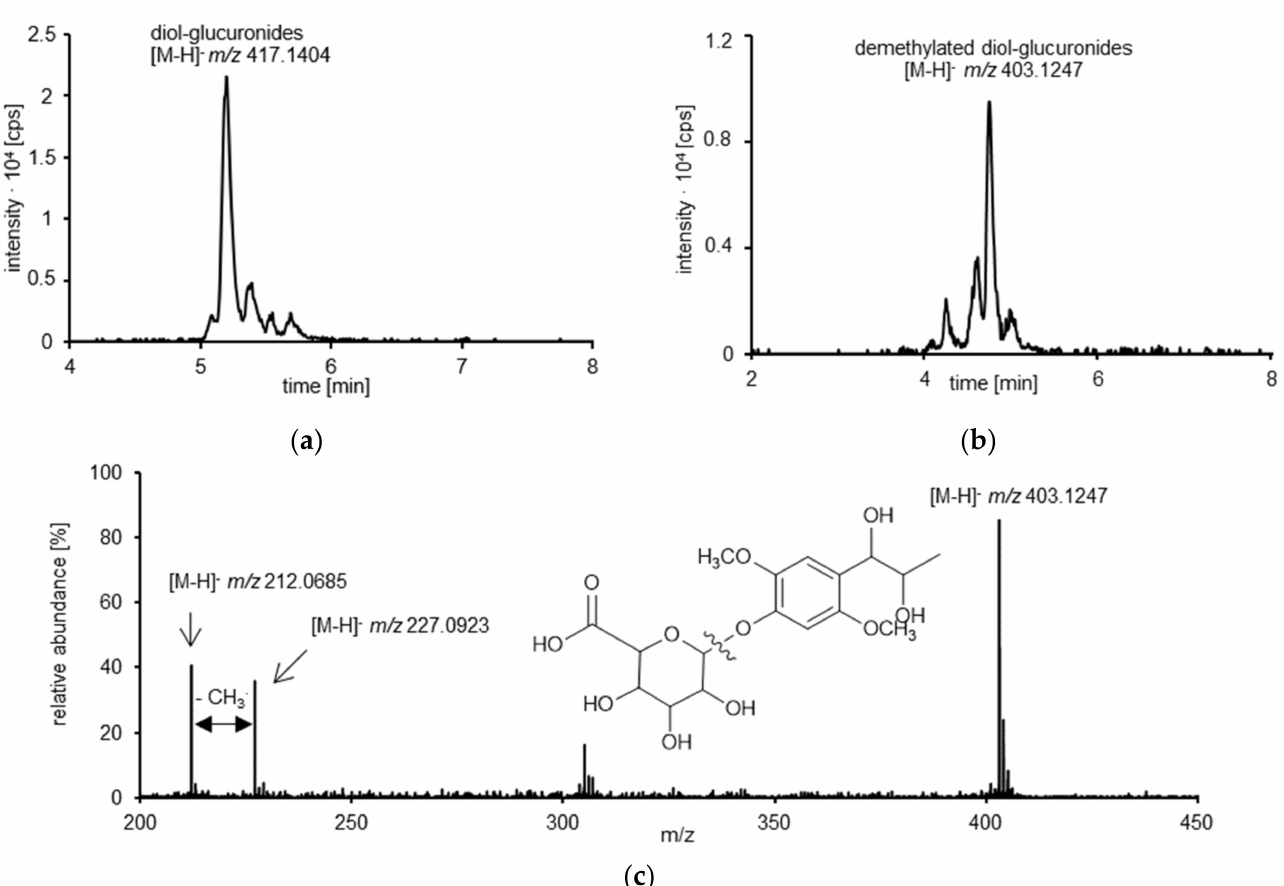
Figure 5. Exemplary HPLC-qTOF-MS chromatograms of a randomly selected urine sample before enzyme treatment. Presented are the extracted-ion chromatogram (XICs) with the calculated mass for ( a ) erythro - and threo -asarone diol glucuronides (diol-glucuronides, m / z 417.1404 ± 0.02) and ( b ) demethylated erythro - and threo -asarone diol glucuronides (demethylated diol-glucuronides, m / z 403.1247 ± 0.01). ( c ) HPLC-qTOF-MS spectrum of the O -demethylated erythro - and threo -asarone diol glucuronides ( m / z 403.1247 ± 0.01) with the respective structural formula. The fragment m / z 227.0923 ± 0.02 corresponds to the O -demethylated metabolites after glucuronic acid cleavage. The loss of a further methyl group is shown by the exact mass of m / z 212.0685 ±